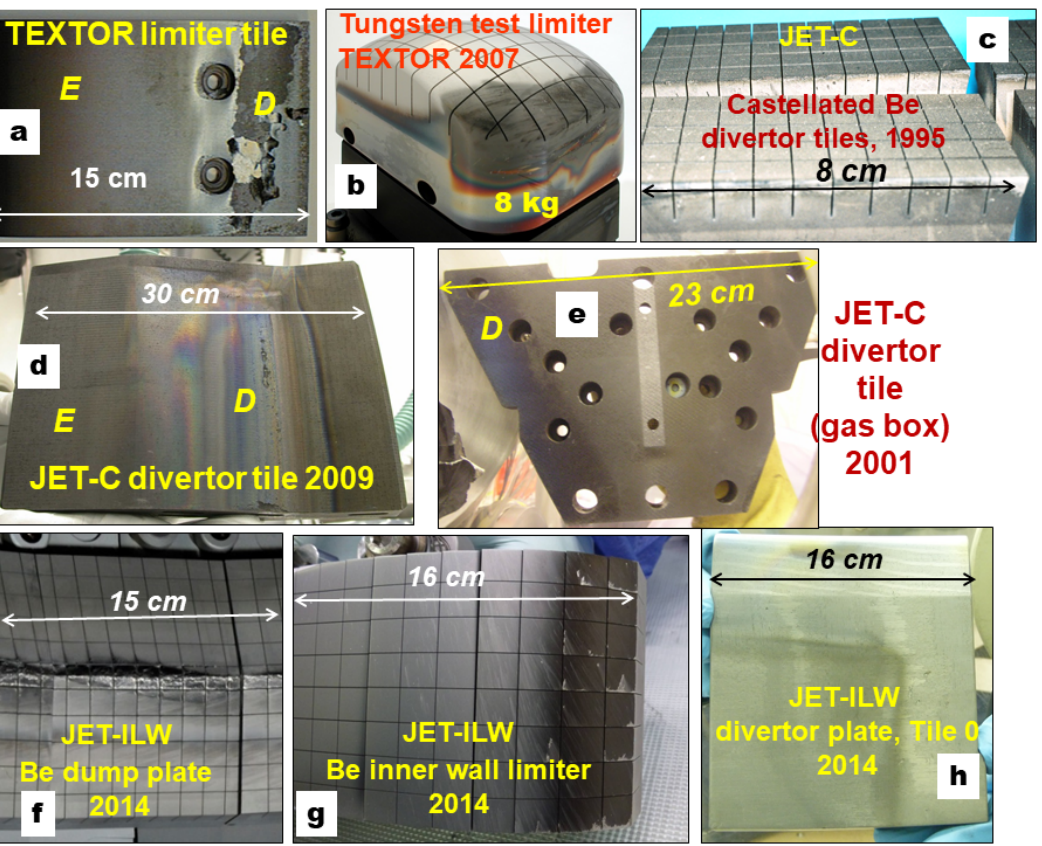
Figure 2. Plasma-facing components from TEXTOR and JET tokamaks: ( a ) graphite plate from the toroidal belt pump limiter; ( b ) castellated test limiter made of bulk W; ( c ) castellated Be tiles from Mk-I-Be divertor; ( d ) CFC tile from Mk-II divertor; ( e ) CFC tile from the septum structure of the Mk-II Gas Box divertor; ( f ) castellated upper dump plate (upper divertor) made of bulk Be; ( g ) castellated tile of the inner wall guard limiter made of bulk Be; ( h ) W-coated CFC tile from the upper part of the inner divertor. “E” and “D” denote erosion and deposition zones, respectively, on the corresponding plasma-facing components (PFC).